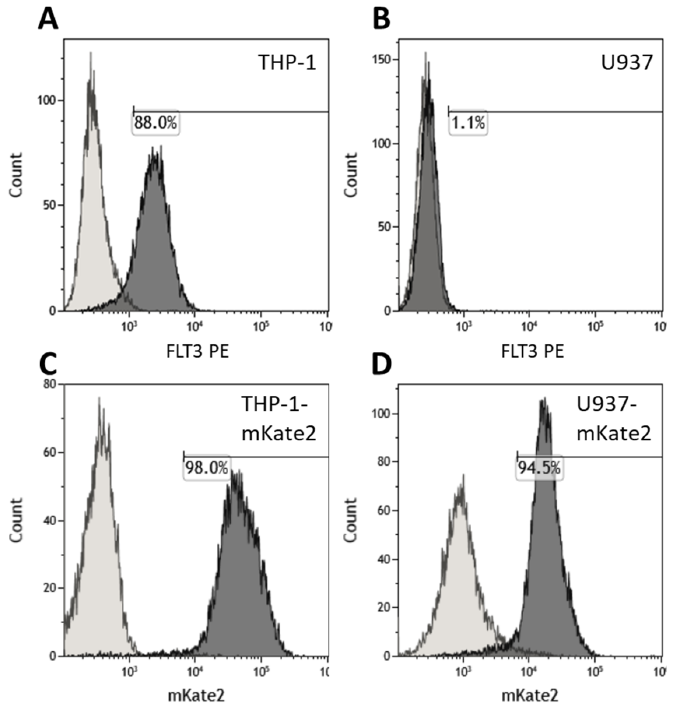
Figure 2. Characterization of the target cells lines THP-1, U937, THP-1-mKate2, and U937-mKate2 by flow cytometry. ( A , B ) Levels of positivity for Flt3 in THP-1 and U937 populations, respectively, measured by staining with anti-CD135-PE antibody. ( C , D ) The 98.0% positive THP-1-mKate2 and 94.5% positive U937-mKate2 were obtained by transduction of THP-1 and U937 cell lines with mKate2 followed by selection on puromycin.